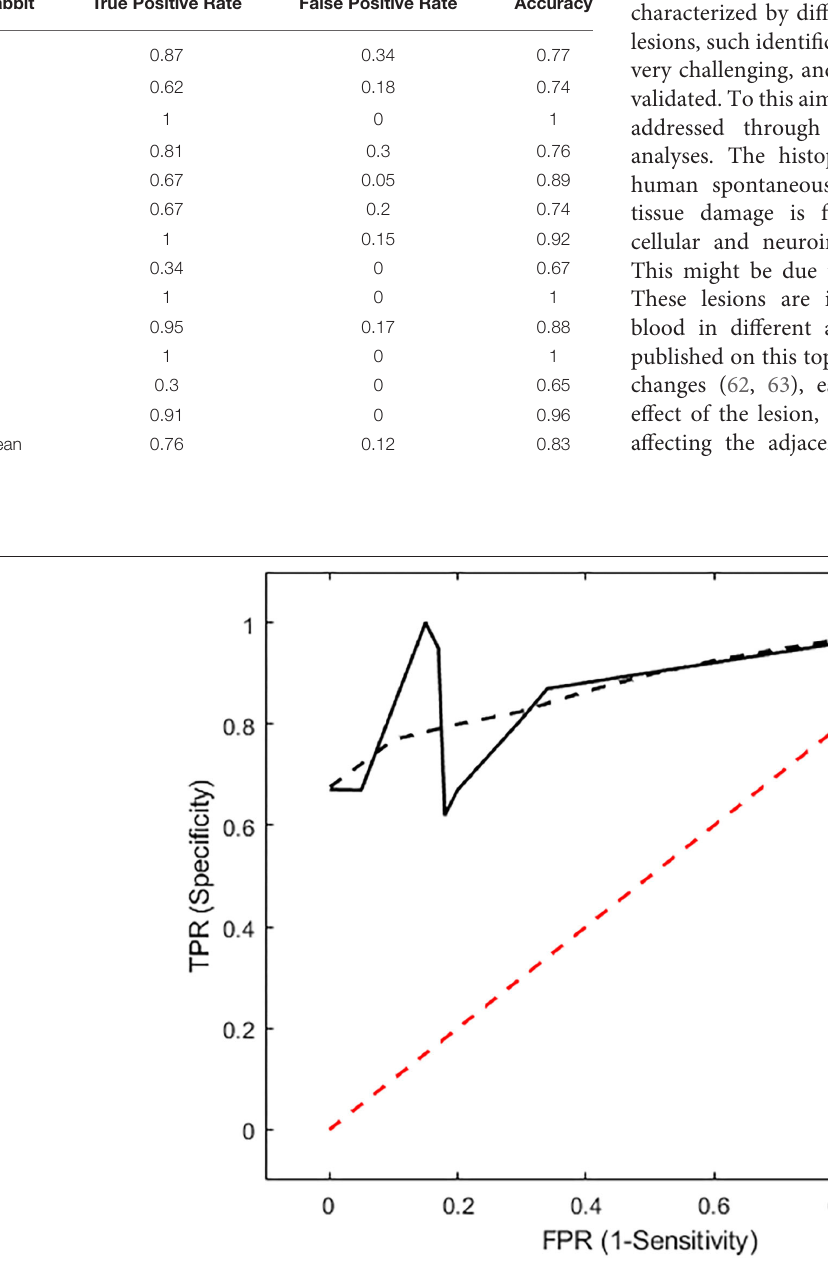
FIGURE 7 | ROC analysis. The ROC curve shows that the classifier performance (black line) is beyond the chance level (red line). When the original data, reported in Table 2 are used, AUC = 0.88. To minimize the effects of TPR fluctuations due to the small sample size, we smoothed these values by means of a smoothing spline (black dashed line). In this case, AUC = 0.80. The AUC values, as compared to the thresholds reported in Materials and methods, place the performance of the classification at the “moderately accurate” level (AUC = 0.9).